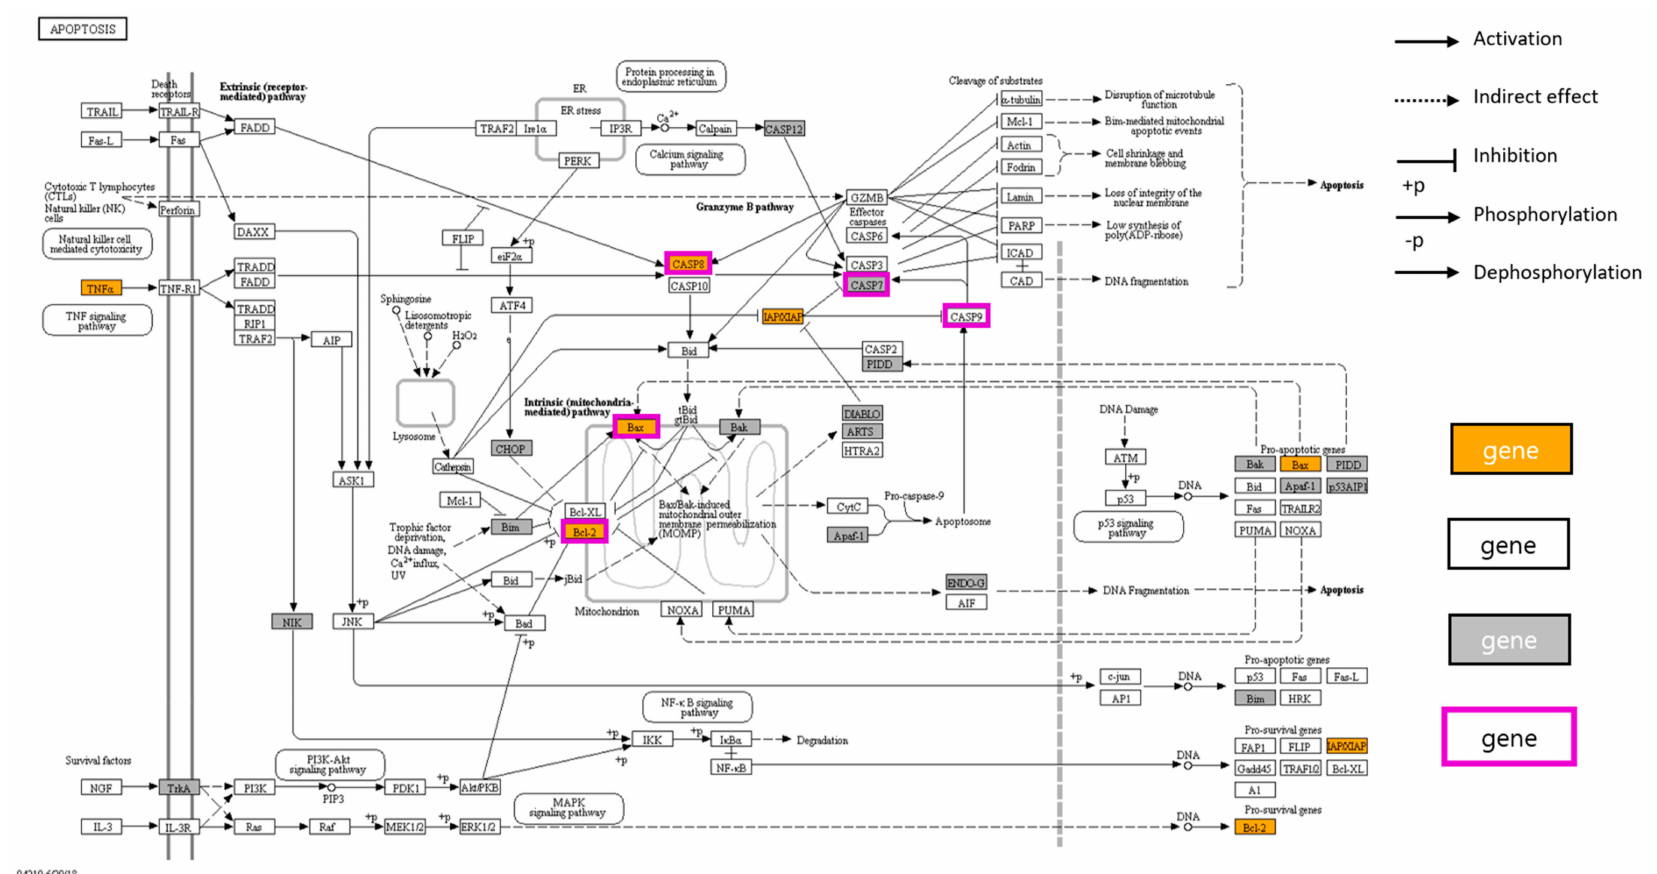
Figure 5. Apoptosis pathways (hsa04210) and targets of cordycepin. The pathway maps were constructed using KEGG mapper. The orange colored box represents a predicted target to interact cordycepin, the uncolored box represents a target that is expected to not interact, the gray colored box represents a target which is outside the predictable target list in TCM-mesh, and the purple-bordered box represents a validated target by western